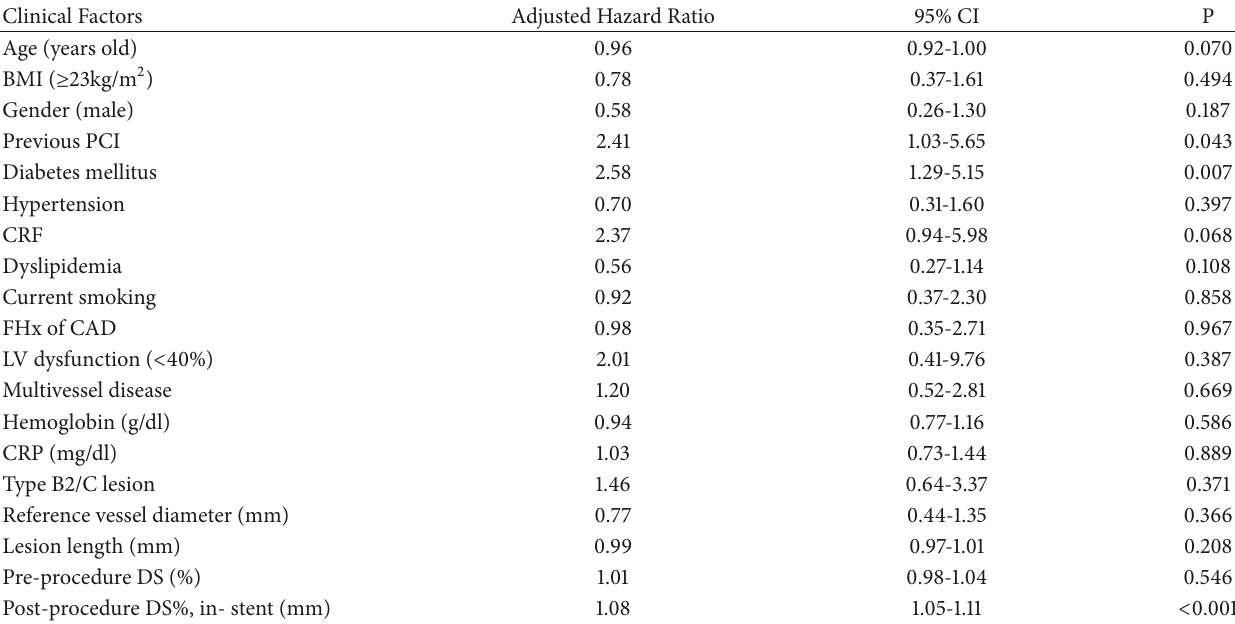
Table 3: Predictors of early TLR.